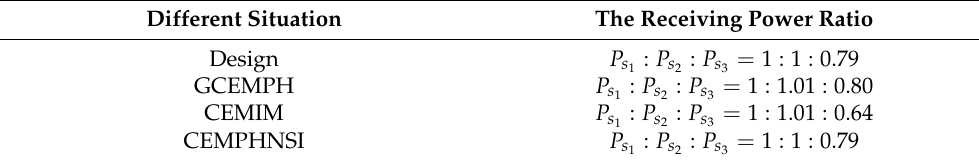
Table 1. The receiving power ratio of different multiplexing signal and of designed signal. Different Situation The Receiving Power Ratio Design